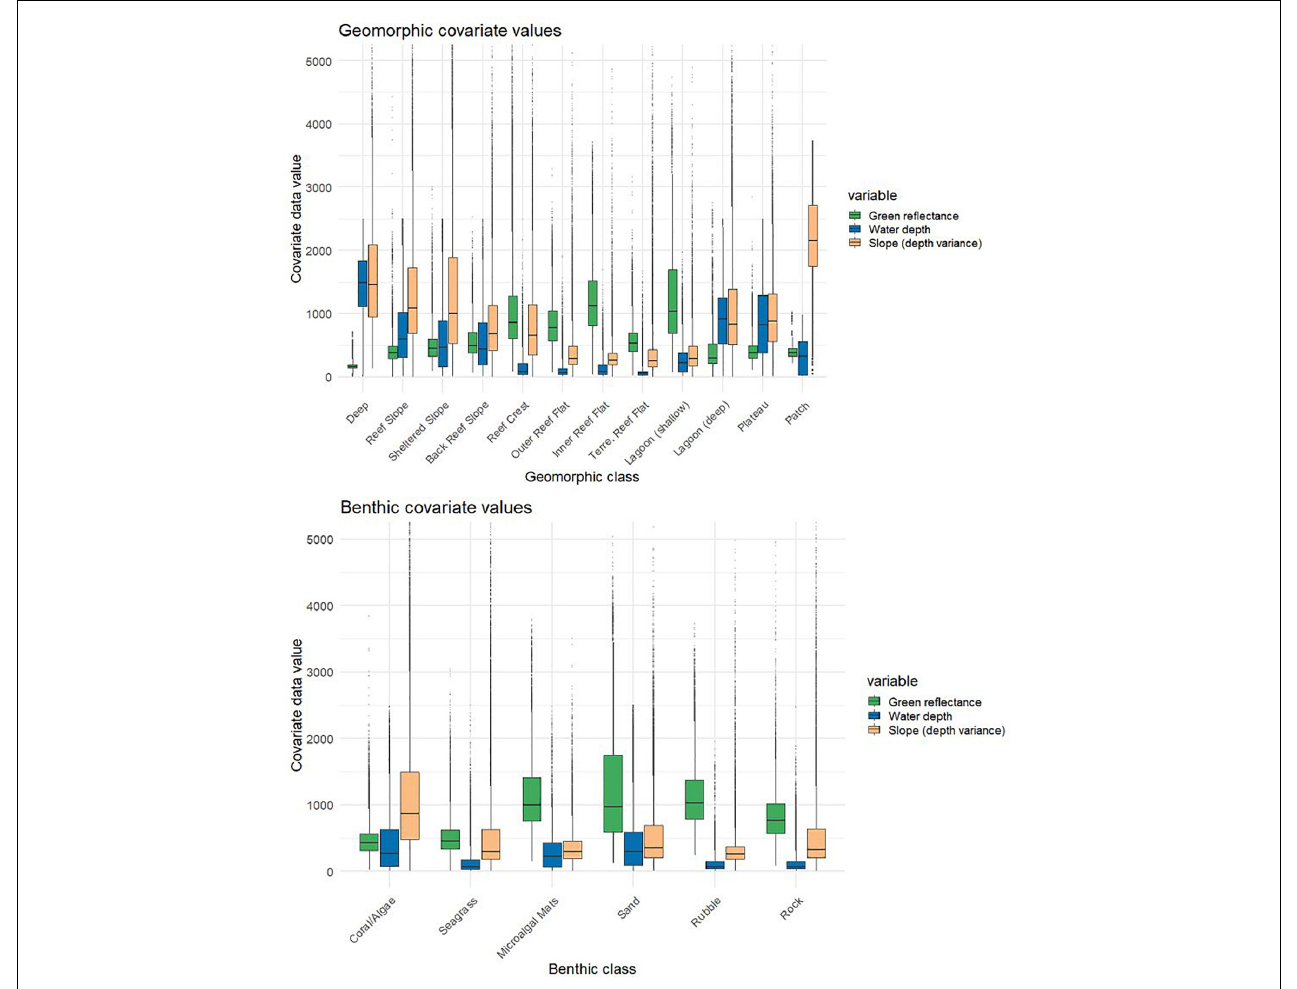
FIGURE 6 | Box plots of covariate values [Planet Dove green reflectance, water depth, slope (stdevDepth)] for each of the map classes for geomorphic and benthic for the regions collectively. Green band reflectance was shown as it showed more variation then the blue and red